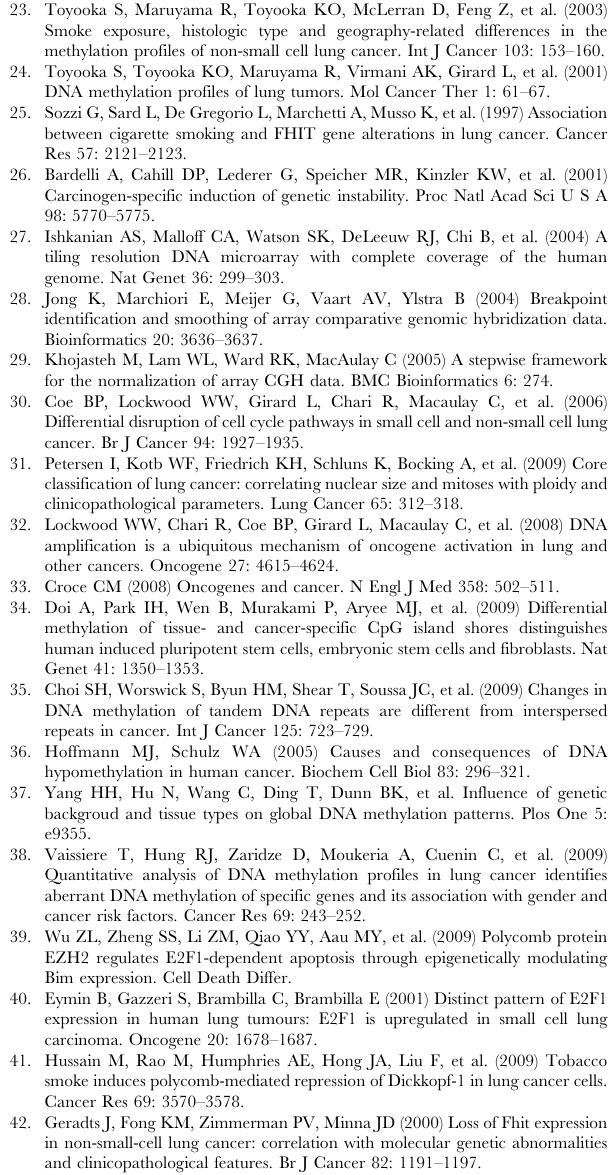
Table S10 Survival analysis of subtype-specific genes. Table S11 CMAP analysis of subtype-specific